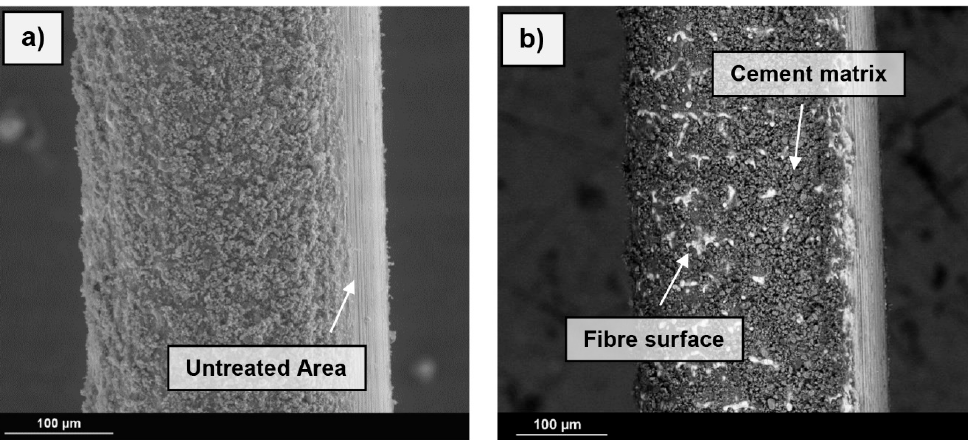
Figure 10. ( a ) Roughened steel fibre after pullout (SE-Image). ( b ) Roughened steel fibre after pullout (BSE-image). Low-vacuum mode, voltage 15 kV, working distance 10 mm.